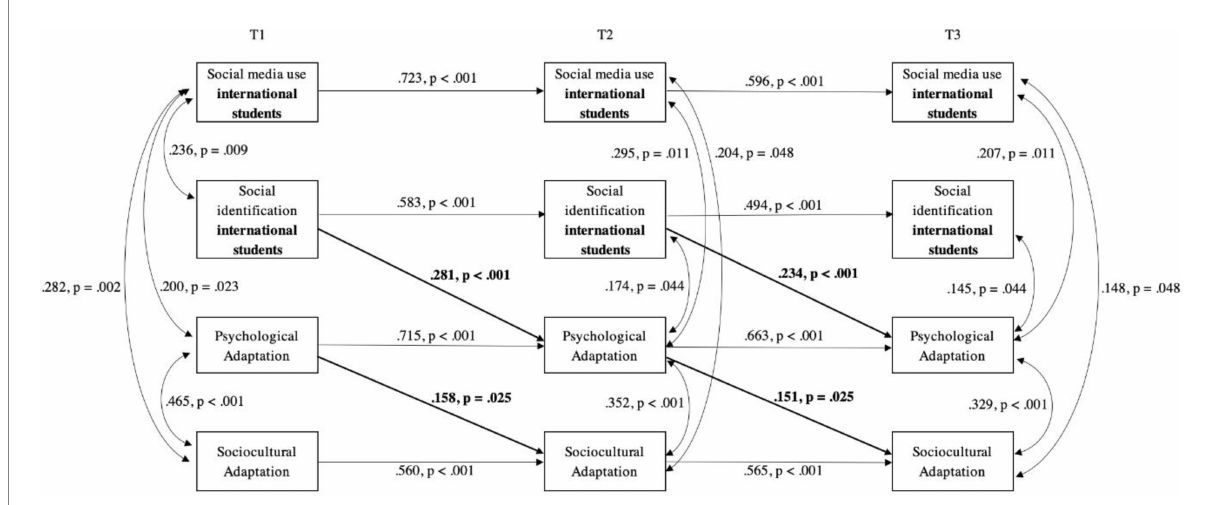
FIGURE 4 Cross-lagged panel model with three time points of the relationships between social media use and social identification with other international students, and psychological and sociocultural adaptation of international students. Only significant paths are shown. Results have been standardized and constrained to equality between time points. Model Fit: χ 2 (38) = 45.069, p = 0.200, CFI = 0.978; TLI = 0.966; SRMR = 0.057; RMSEA = 0.029, 90% CI [0.000, 0.059], p close = 0.897; N =